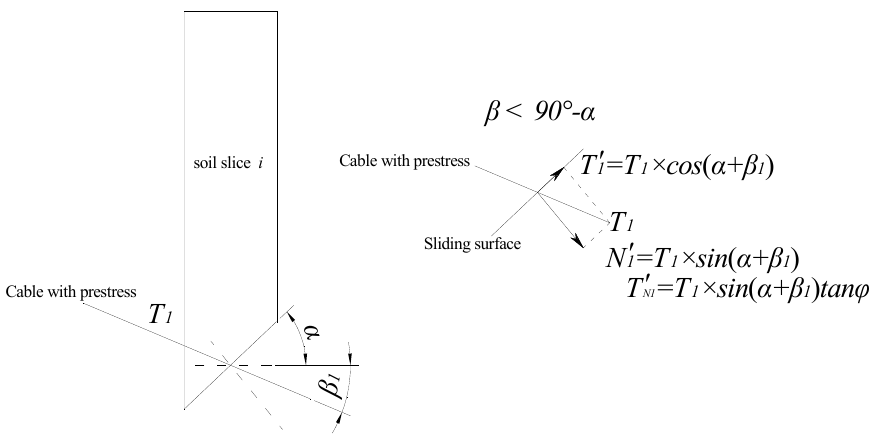
Figure 10. The reinforcement function of an anchor cable on a sliding surface.